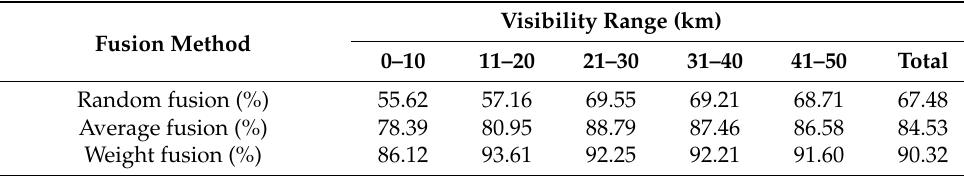
Table 7. Visibility accuracy of different fusion